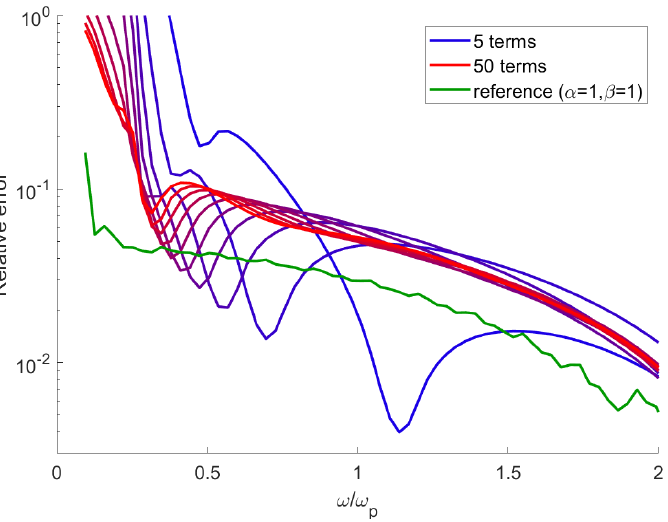
Figure 2. Relative error of the model for α = 0.8, β = 0.8. Standard Drude model (green line) added for reference.